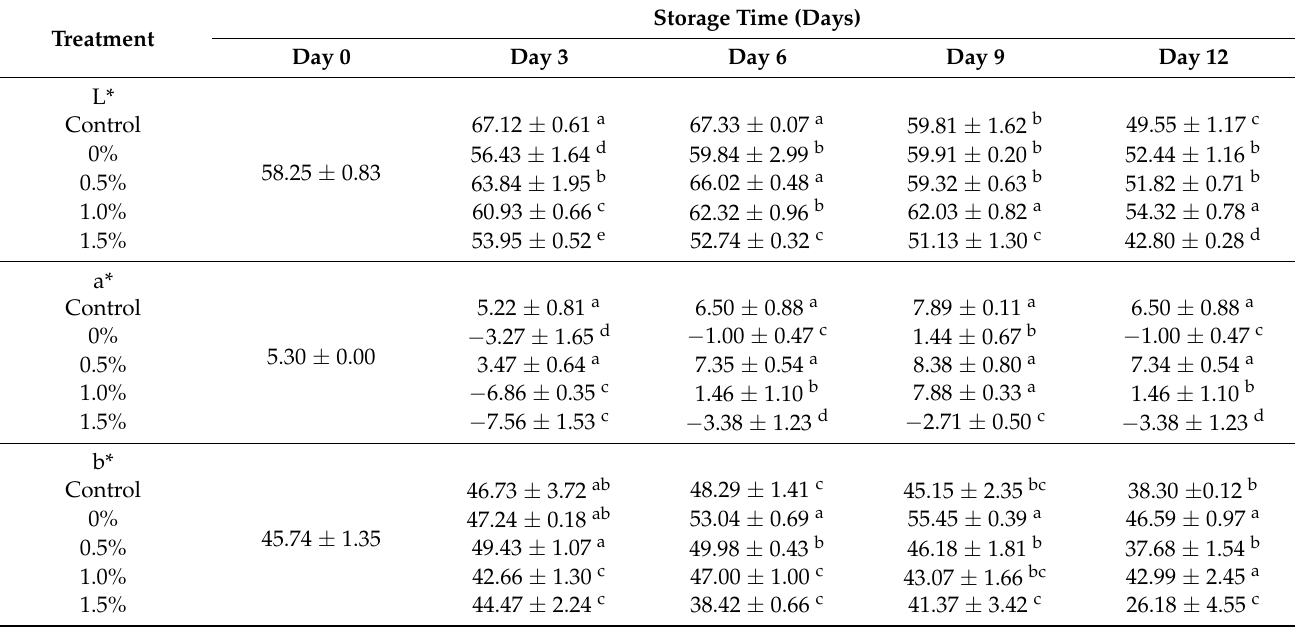
Table 4. Effect on color characteristics of bananas coated with different concentrations of D-limonene nanoemulsion edible film and stored at 13 ± 1 ◦ C from 0 to 12